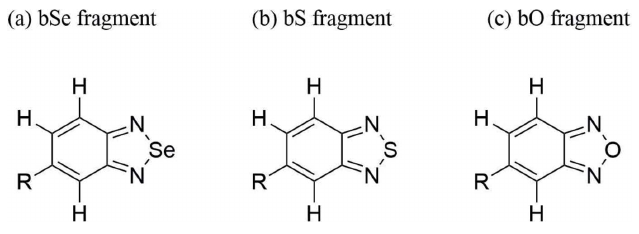
Figure 10 Fragments searched for in the CSD during the database survey analysis: ( a ) bSe fragment ( b ) bS fragment ( c ) bO